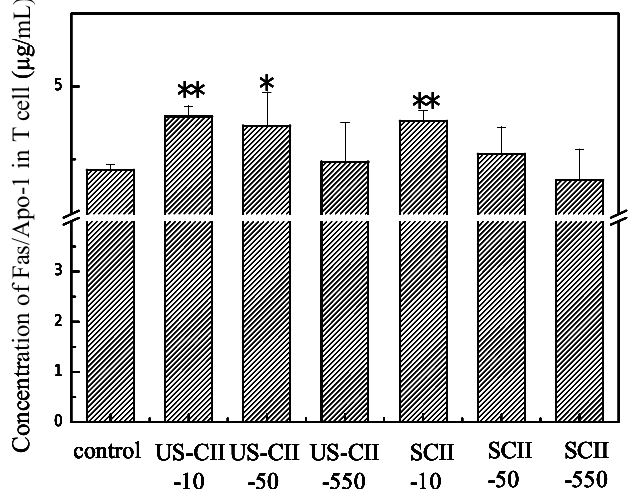
Figure 6. Effects of different CII on the concentration of Fas/Apo-1: The level of Fas/Apo-1 in the medium was measured by ELISA according to protocols of Human Fas/APO-1 ELISA